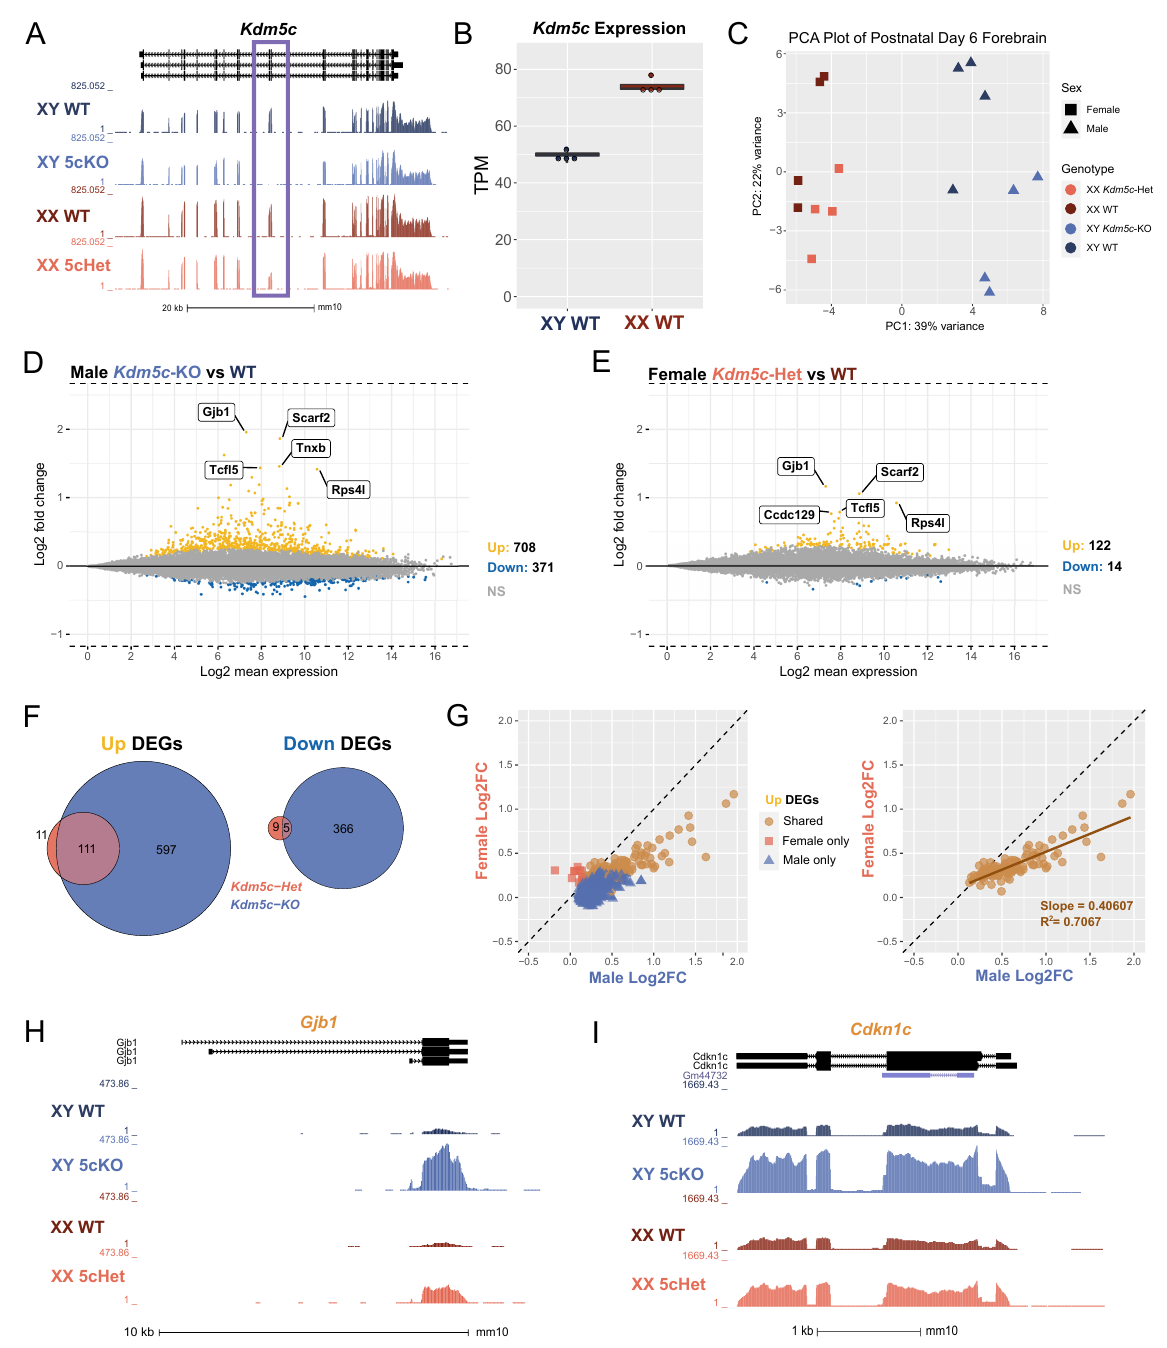
Figure 1. Loss of Kdm5c results in dose-dependent transcriptional dysregulation in the male and female mouse brain. ( A ). UCSC genome browser view displaying the transcription of Kdm5c in the P6 forebrain of wild type male (XY WT), Kdm5c knockout male (XY 5cKO), wild type female (XX WT), and Kdm5c heterozygous (XX 5cHet). Purple box highlights deletion of exons 11 and 12 in 5cKO and half reduction in 5cHet. ( B ). Comparison of Kdm5c RNA expression between wild-type male and female samples as transcripts per million (TPM). ( C ). Principal component analysis (PCA) of all mRNA-seq replicates. ( D , E ). MA plots of DESeq2 results from male and female brains with Kdm5c loss. Differentially expressed genes (DEGs), defined as a q-value < 0.1. DEGs upregulated from WT in yellow (Up) and downregulated from WT in blue (Down). Gray is non-significant genes (NS).